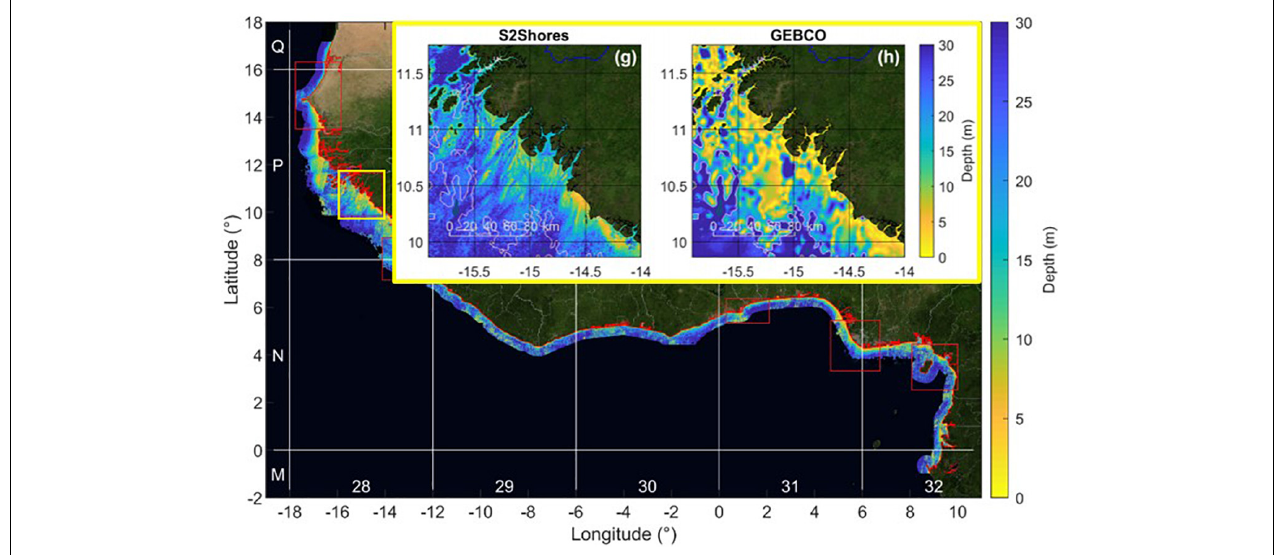
FIGURE 2 | West African coastal bathymetry derived from Sentinel-2 optical data. The shoreline is indicated by the red line. The inset shows the SDB estimate (left) and the GEBCO bathymetry (right) for the region encompassed in the yellow square in the main panel. Adapted from Daly et al.